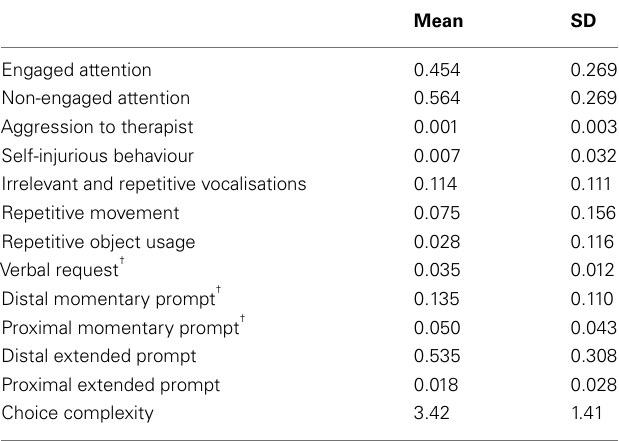
Table 5 | Descriptive statistics for normalised